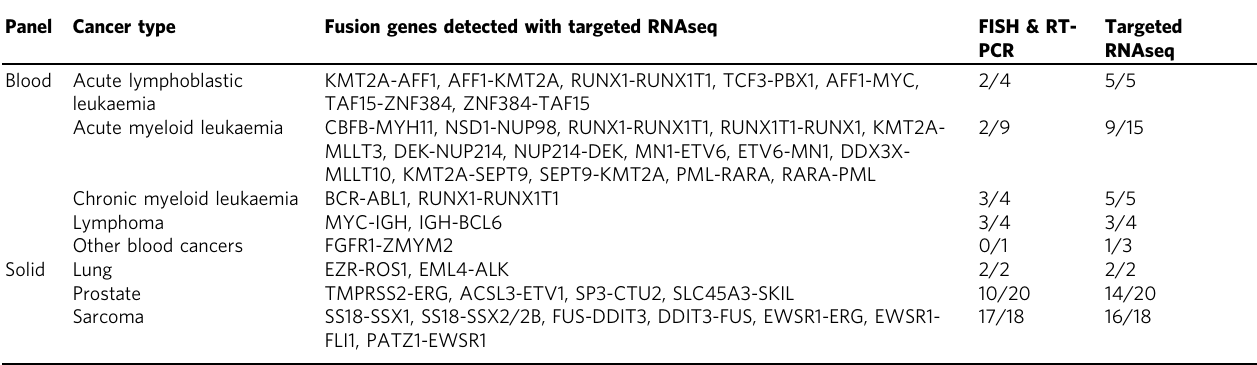
Table 2 Fusion genes found within the clinical cohort Panel Cancer type Fusion genes detected with targeted RNAseq Blood Acute lymphoblastic